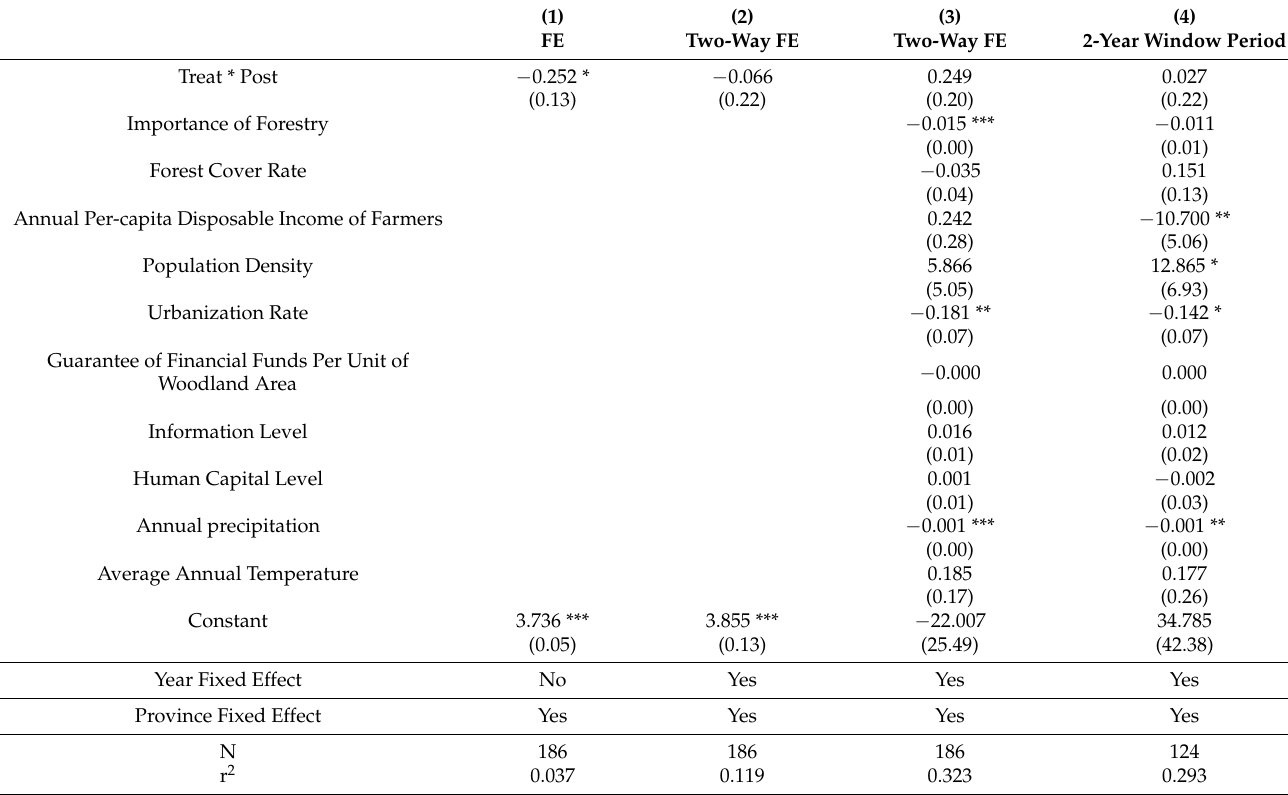
Table 6. Fixed-effects regression model results: logarithm of total forest